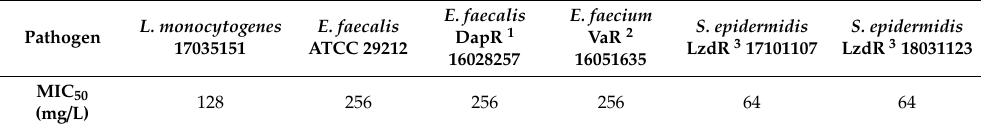
Table 4. Minimal inhibitory concentrations are effective for ≥ 50% for 2 against other Gram-positive bacteria.